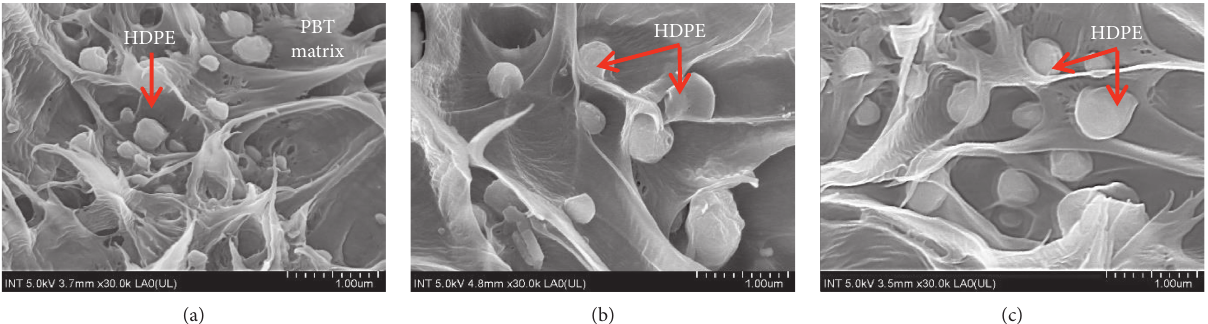
Figure 16: SEM micrographs of the PBT/HDPE blend with different weight percents of HDPE (30000 × magnification): (a) 5% HDPE, (b) 10% HDPE, and (c) 15%